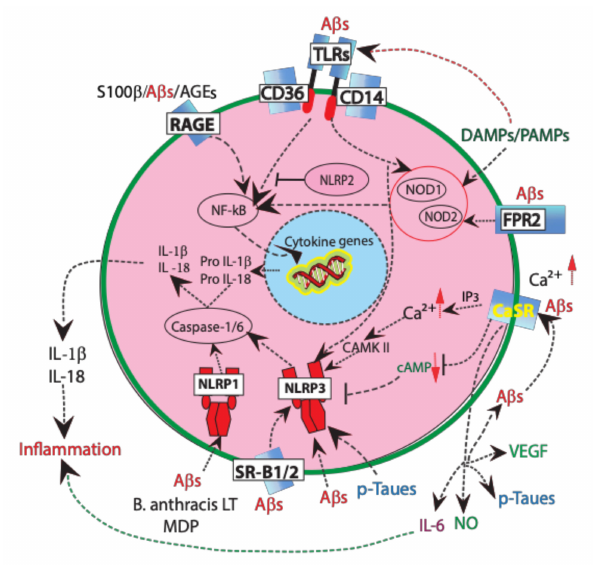
Figure 2. A schematic representation of some of the main PRRs and their signaling pathways involved in AD’s neuroinflammation. The cell represented could belong to any neural cell type. A β s, soluble and / or fibrillar amyloid- β peptides; FPR2, formyl peptide receptor 2; IP3, inositol triphosphate; LT, lethal toxin; ↑ , upregulation; ↓ , downregulation. For further details and abbreviations see the text. The expression of these various DAMPs increases in course of chronic inflammatory ailments